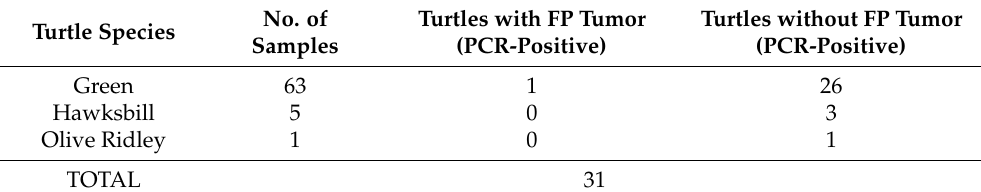
Table 2. Detection of ChHV5 in tissues with and without FP tumors in the green, hawksbill, and olive ridley turtles.